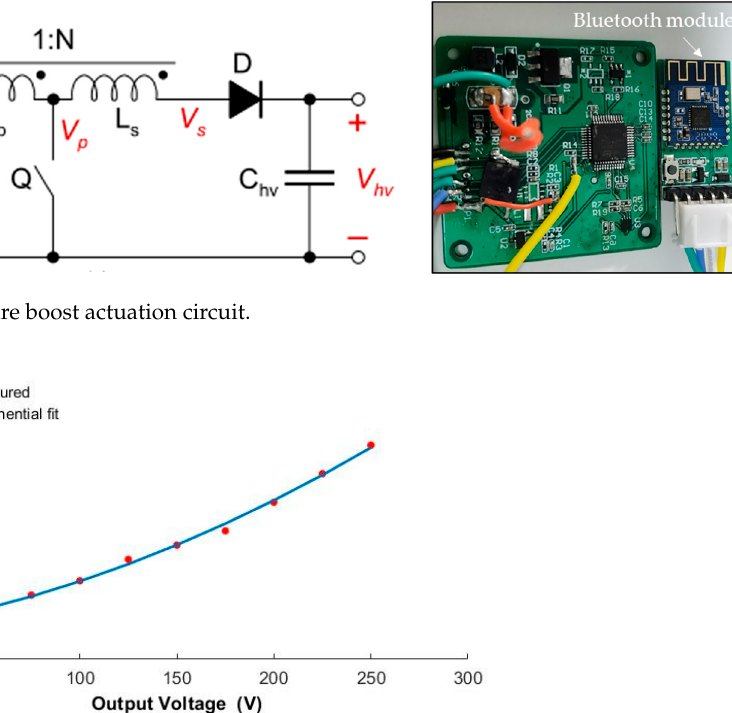
Figure 6. Low-voltage input current versus high-voltage output generated by the boost converter.